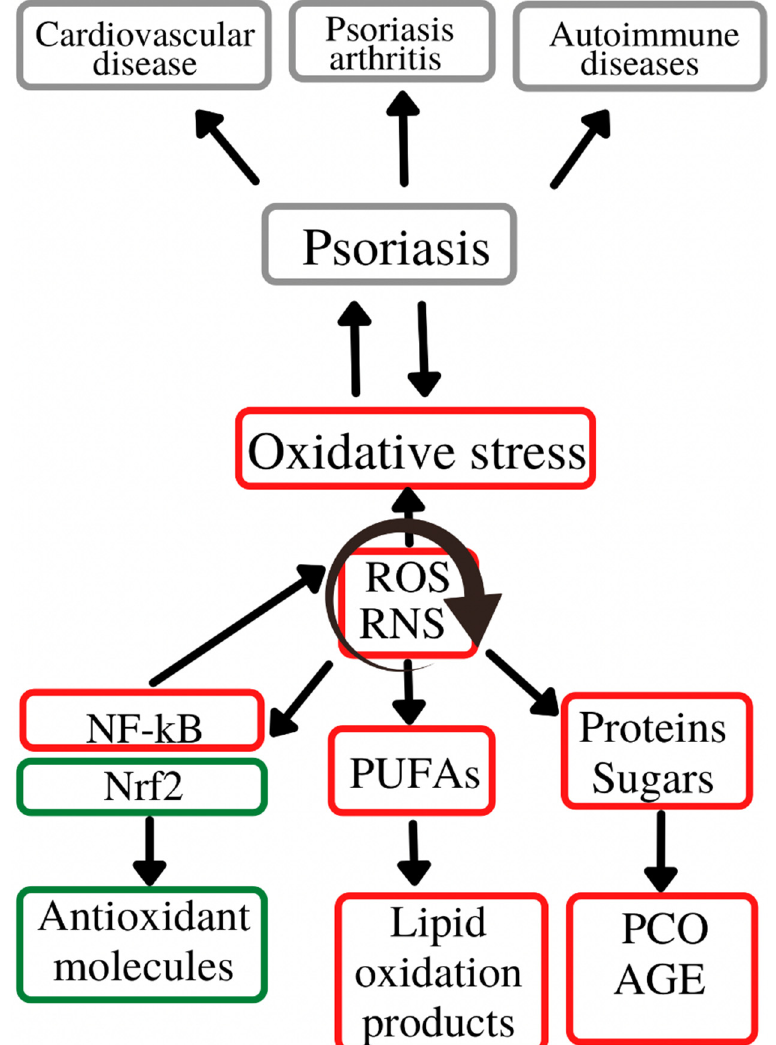
Figure 2. Oxidative stress in the psoriasis evolution. Oxidative stress plays an important role in the initiation and evolution of psoriasis and its associated-comorbidities/complications (cardiovascular diseases, psoriasis arthritis and autoimmune diseases. These complications are generated by the chronic action of ROS and RNS on the main cell constituents (lipids, proteins and carbohydrates), with a secondary activation of molecular pathways (Nrf2, NF-kB) responsible for inducing synthesis of antioxidant molecules (Nrf2) or pro-oxidant enzymes (NF-kB). ROS—reactive oxygen species; RNS—reactive nitrogen species; Nrf2—nuclear erythroid factor 2-related factor 2; NF-kB—nuclear factor kappa light chain enhancer of activated B cells; PUFAs—polyunsaturated fatty acids; AGE—advanced glycation end-products; PCO—protein carbonyl content.